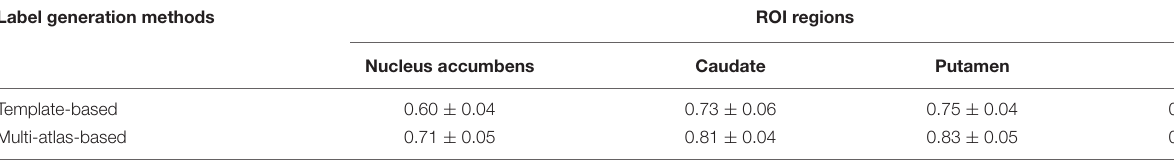
TABLE 2 | Dice coefficients of two label generation methods in ROI regions.